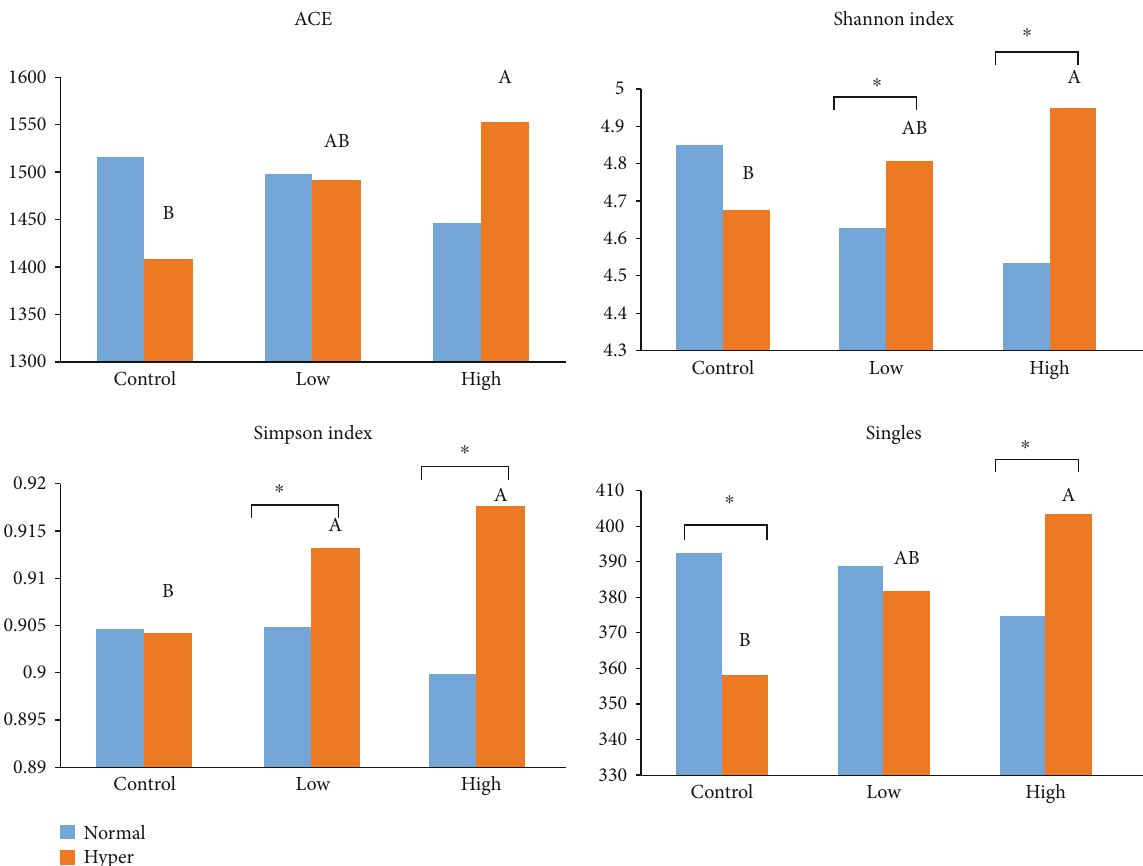
Figure 2: Diversity parameters of ruminal archaea in liquid phase as a ff ected by betaine addition 1 and osmolality 2 . Di ff erent superscripts on hyperosmolality bars represent signi fi cant di ff erence ( P < 0 : 05 ). ∗ P < 0 : 05 . 1 Betaine levels: control (0), low (51), and high (286) ppm. 2 Normal osmolality ~ 295 mOsmolkg − 1 ; hyperosmolality ~ 420mOsmolkg − 1 . Table 4: Measures of alpha diversity of ruminal archaea community in fermenters associated with the solid phase as determined using QIIME and 16S rRNA sequences.